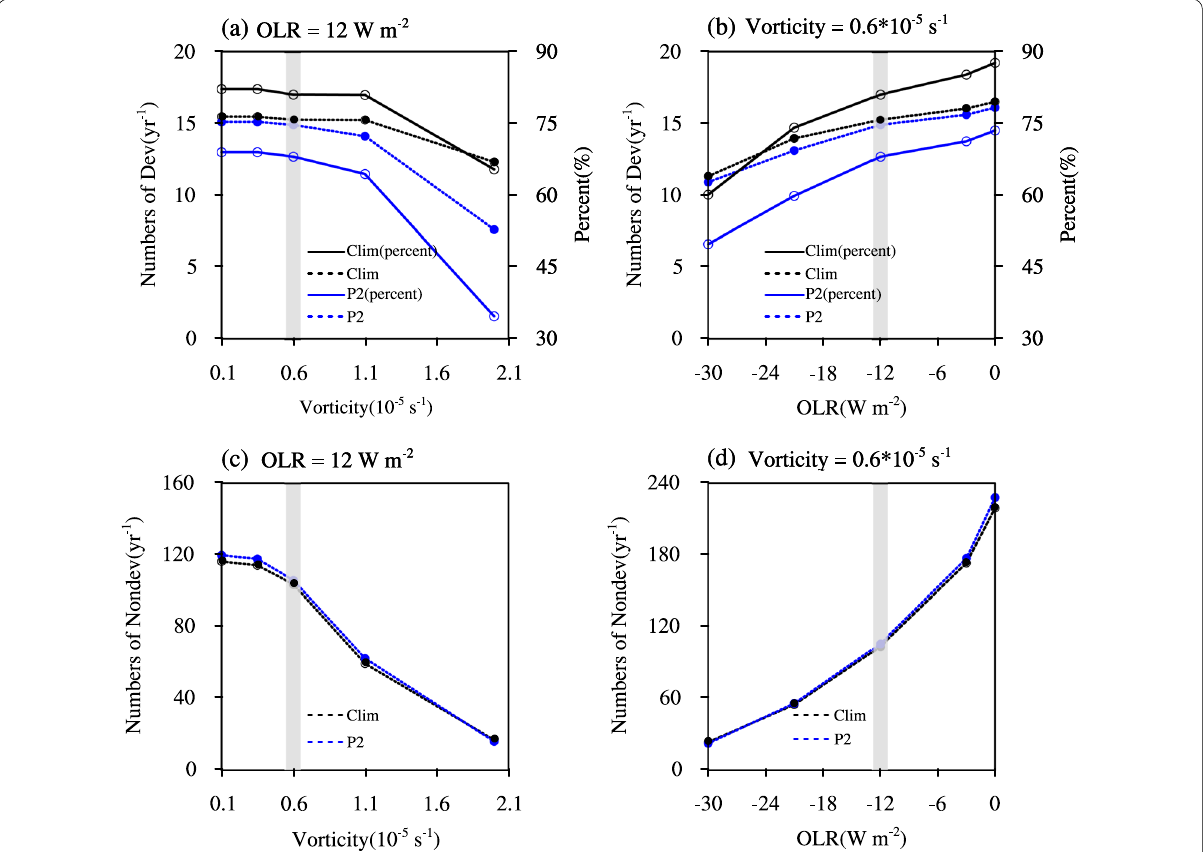
Fig. 9 Different experiments of the number of a developing (dotted line) and c nondeveloping (dotted line) disturbances per year during 1965– 2020 (Clim, black line) and 1988–1997 (P2, blue line), and a the percentage of developing disturbances to TCs (solid line) based on the changes of the thresholds of relative vorticity, the OLR remains 12 W m − 2 in a and c . The black and blue dots denote the thresholds of different experiments. The grey rectangles indicate the threshold that our algorithm use. b , d is the same as a and c , but for the changes in the thresholds of OLR, the relative vorticity remains 0.6 10 –5 s − 1 in b and ×